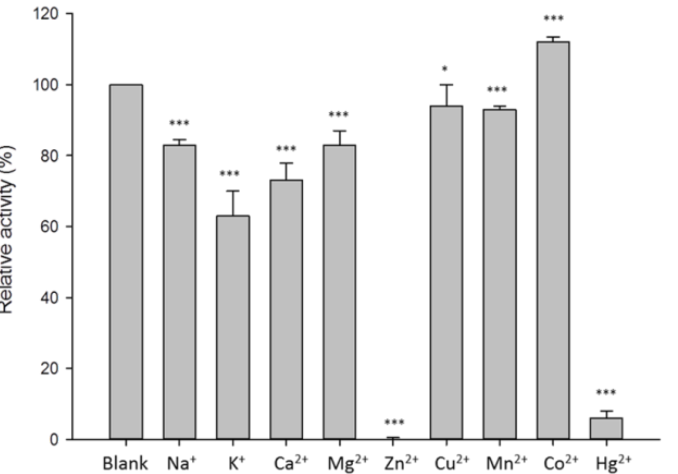
Figure 6. Effect of metal salts on β -1,3-glucanase from Y. lipolytica transformant (pYLSC1- 13g ). Data: mean ± SE from triplicate experiments (Student’s t -test p values: * p < 0.05; *** p <